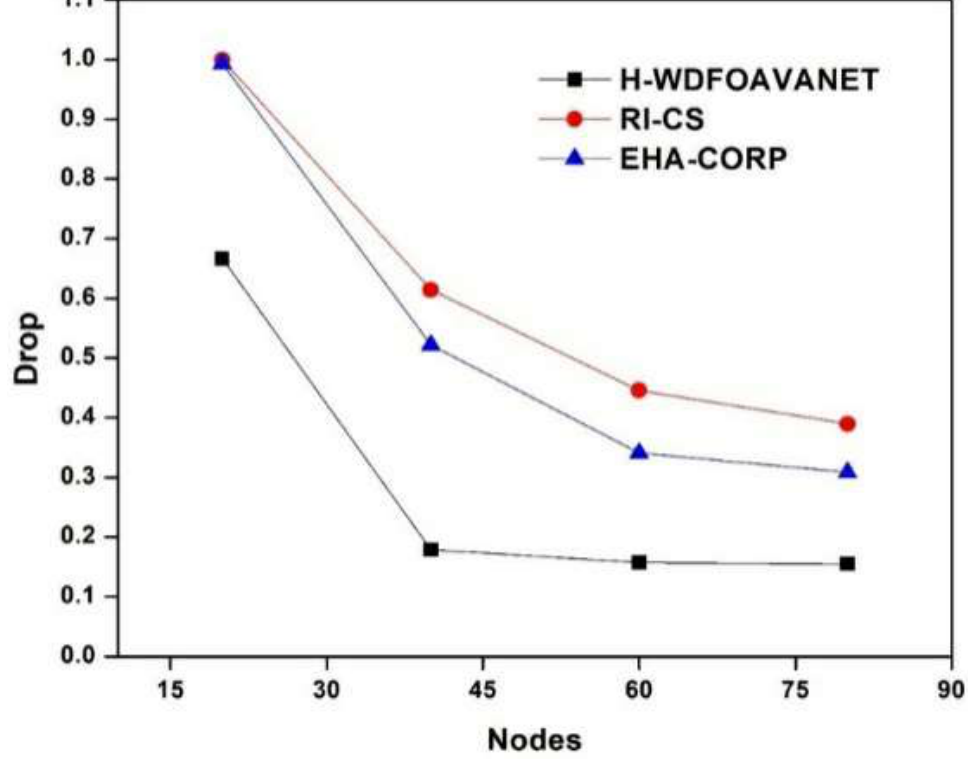
Figure 15. Plots of nodes vs. delays in the suggested approach and existing approaches.